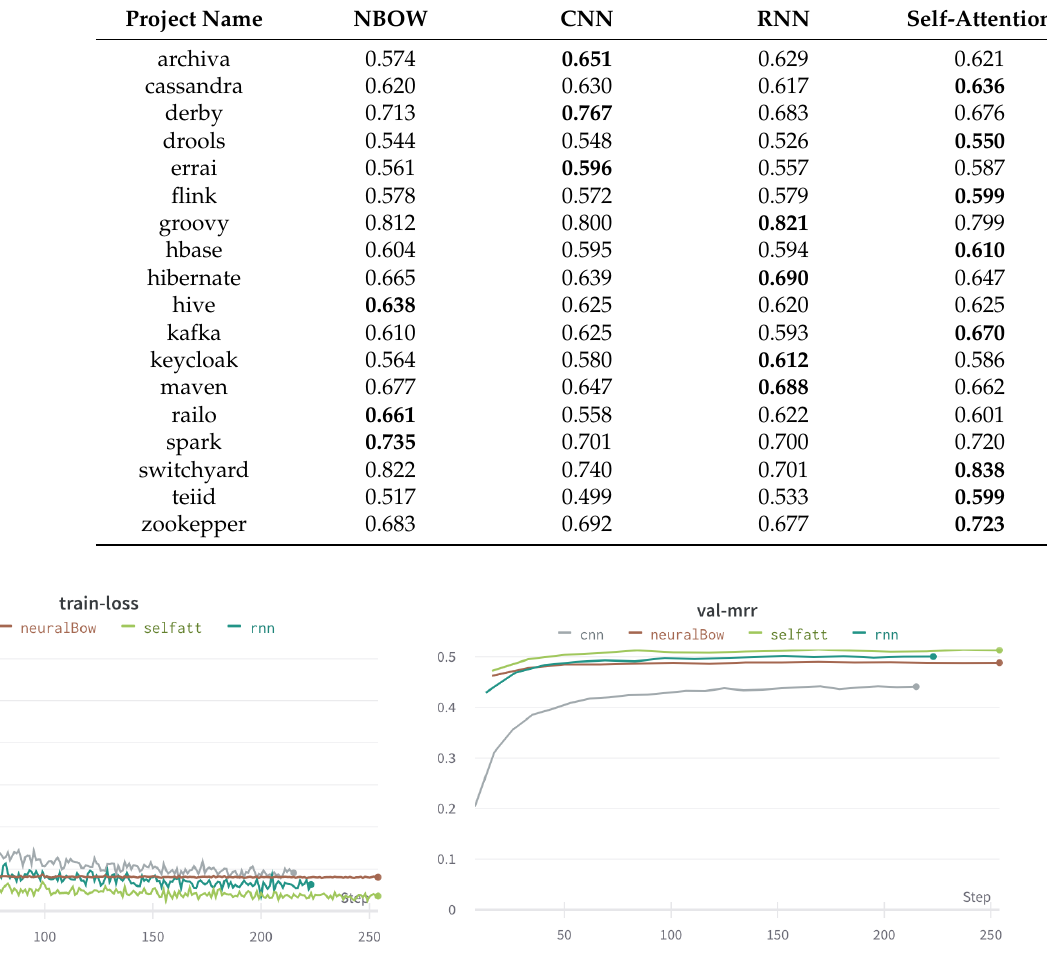
Figure 7. Comparison of learning curve and performance of four embedding neural